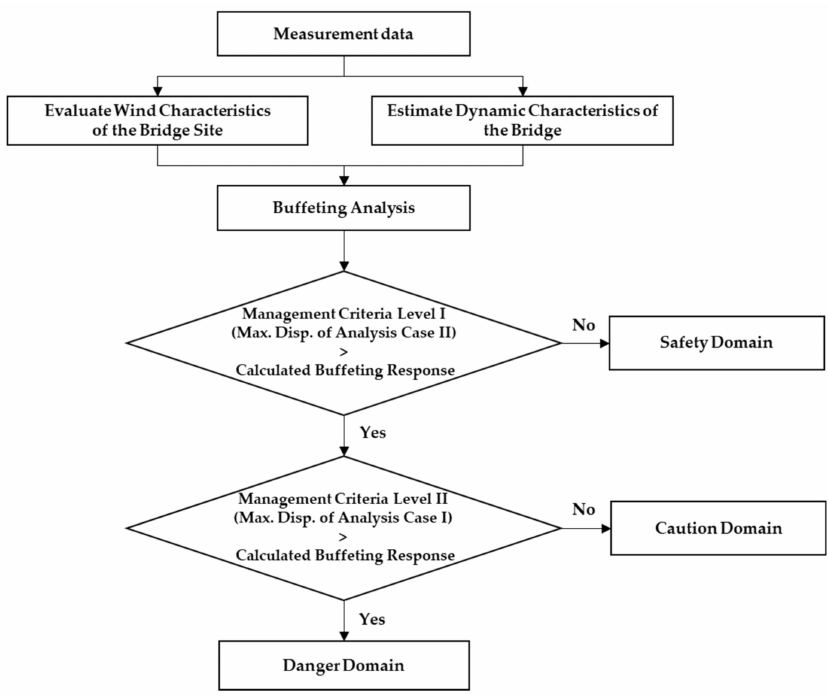
Figure 12. Proposed in-situ data-based management criteria of